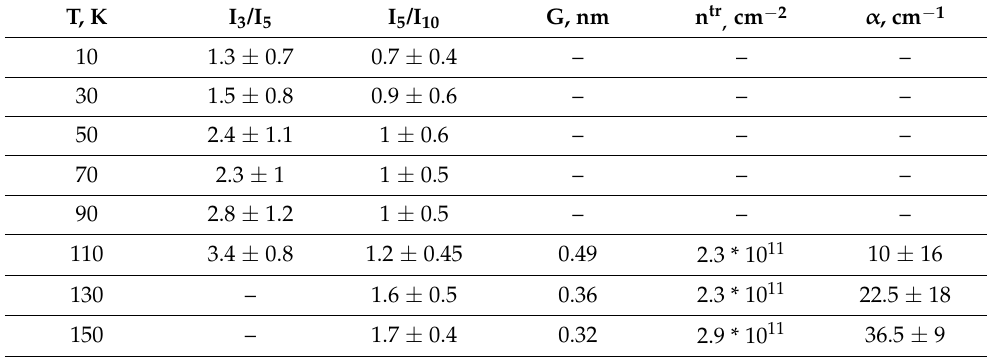
Table 1. The ratio between threshold pumping intensities of structures with 3 and 5 quantum wells (I 3 /I 5 ), 5 and 10 quantum wells (I 5 /I 10 ), calculated values of amplification (G) and transparency concen- tration (n tr ) and loss coefficient ( α ) calculated using the value of I 5 /I 10 for different temperatures (T). T, K I 3 /I 5 I 5 /I 10 G, nm n tr , cm −